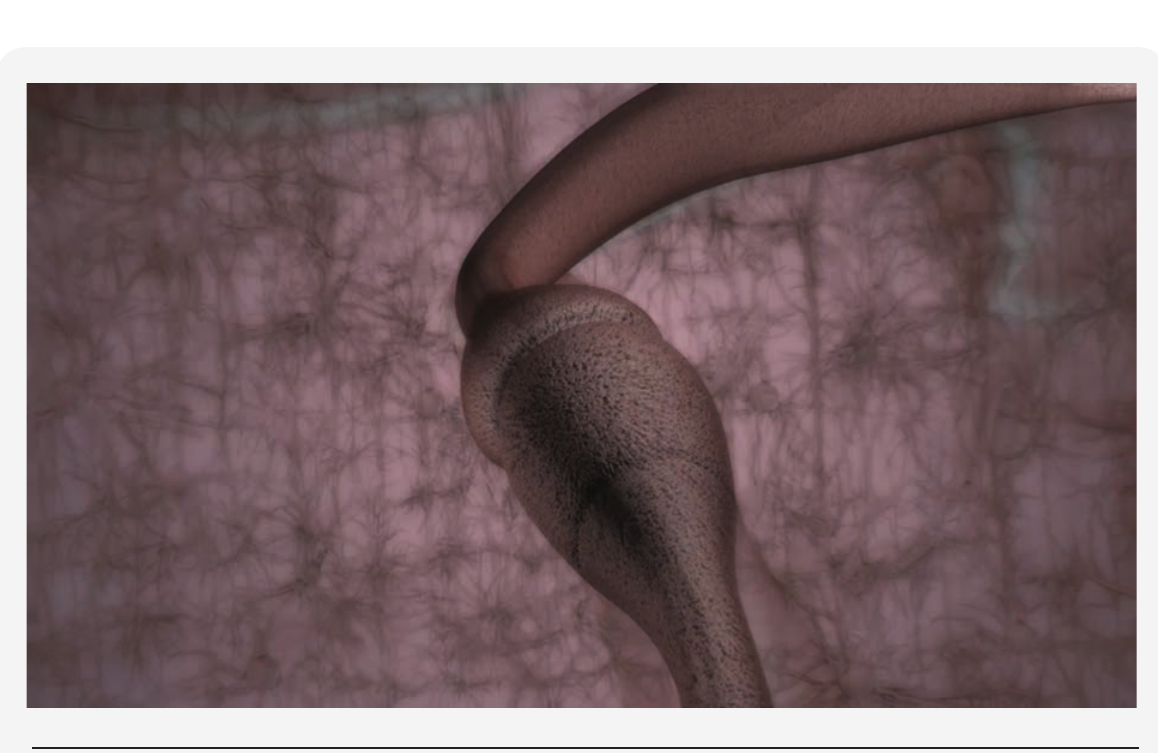
Figure 2. Cartoon of a neural connection (synapse) between two neurons . Chemicals called neurotransmitters are released by one neuron in response to an action potential, and are sensed by receptors on a downstream neuron. These receptors, in turn, drive electrical signals within the downstream neuron, which can generate a new action potential, and the cycle